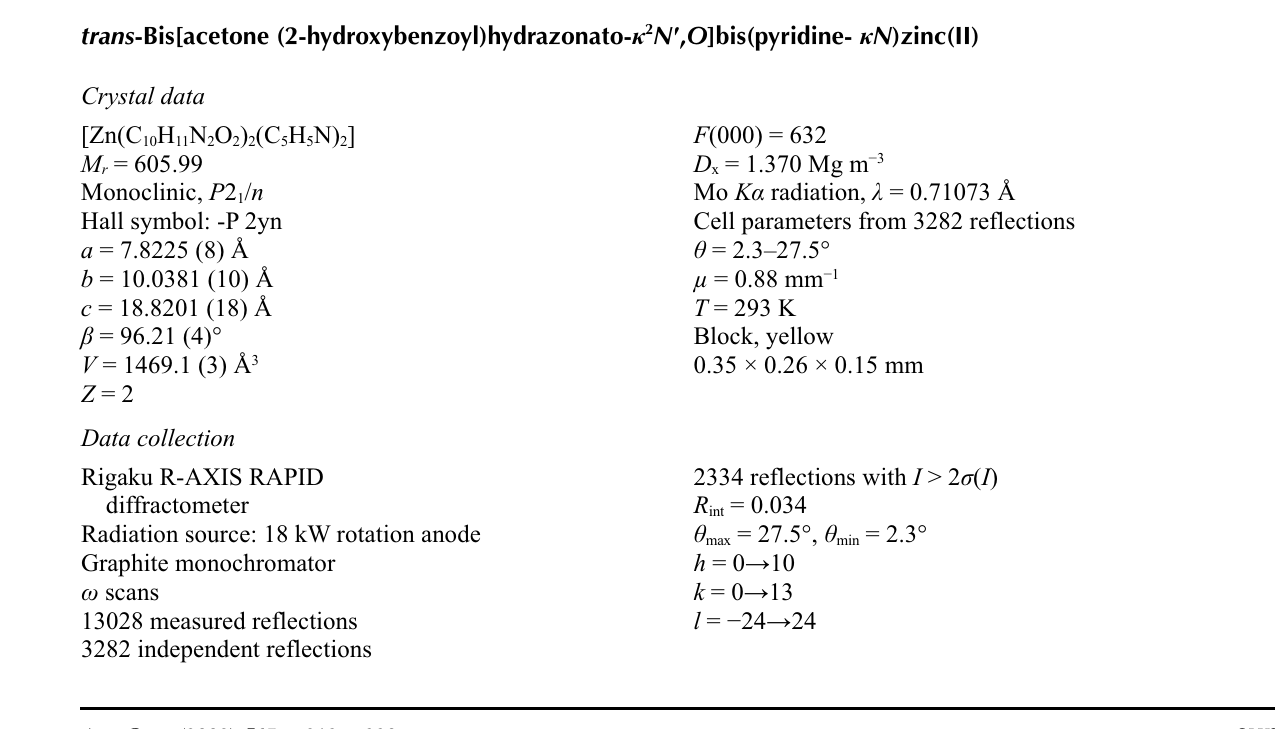
Figure 1 Molecular structure of the title compound. Displacement ellipsoids are drawn at the 30% probability level. Hydrogen bonds are shown as dashed lines. [Symmetry code: (i) 1 - x , - y , - z